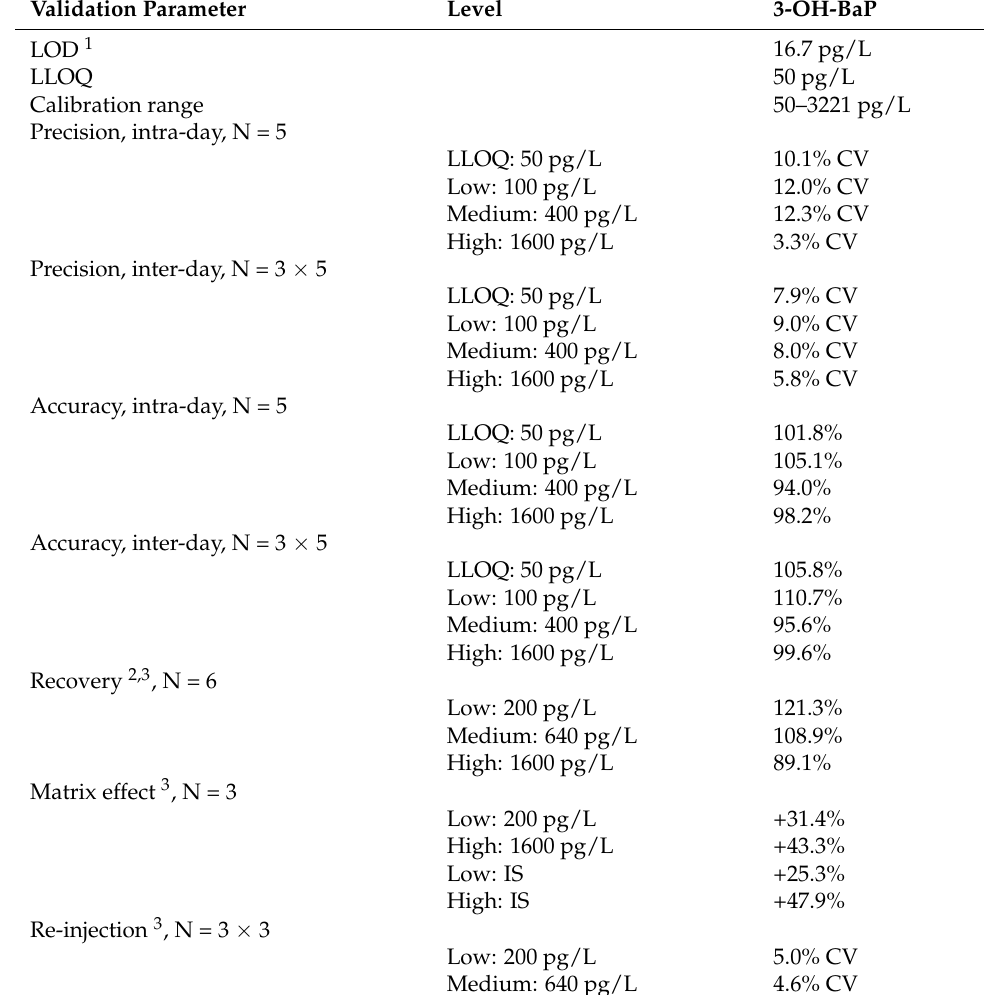
Table 3. Method validation data for the quantification of 3-OH-BaP in